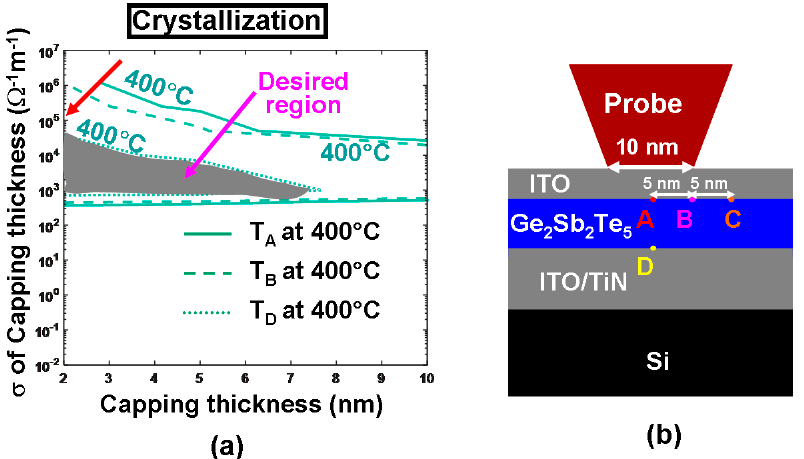
Figure 18. ( a ) Temperature contours at some pre-defined points (A, B, C, D) as a function of electrical conductivities ( σ ) and thickness of the ITO capping layer during crystallization and ( b ) locations of the pre-defined points.